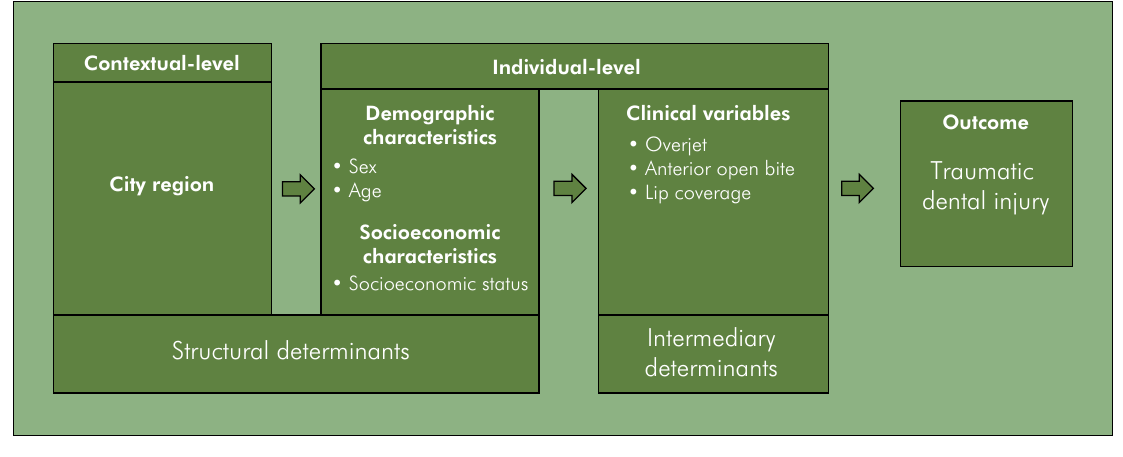
Figure 1. Theoretical model for the study of determinants of TDI in adolescents, adapted from the World Healt